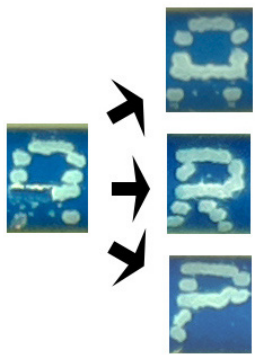
Figure 12. An enlargement of a single character: letter, printed on a wire; left side: the original, faultily printed text with a character that the AI-supported system is challenged to recognize; right side: the